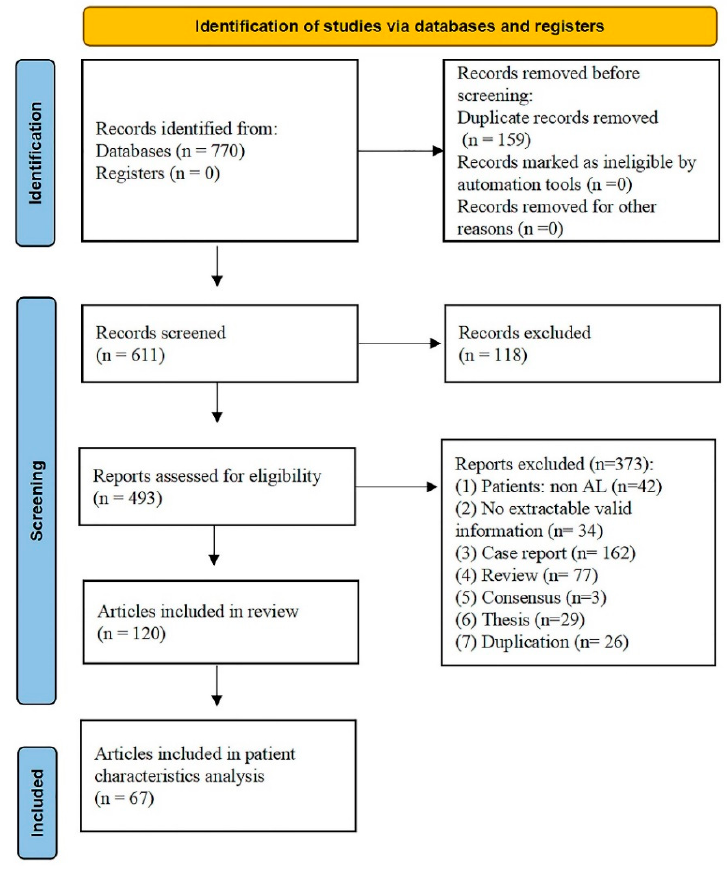
Figure 1. Literature screening flow chart.